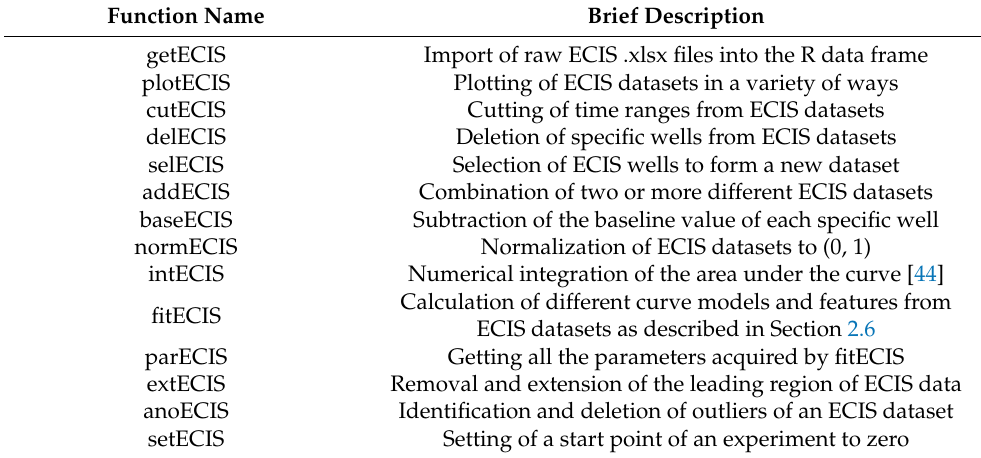
Table 1. Analysis functions implemented as R scripts for the manipulation and quantitation of ECIS